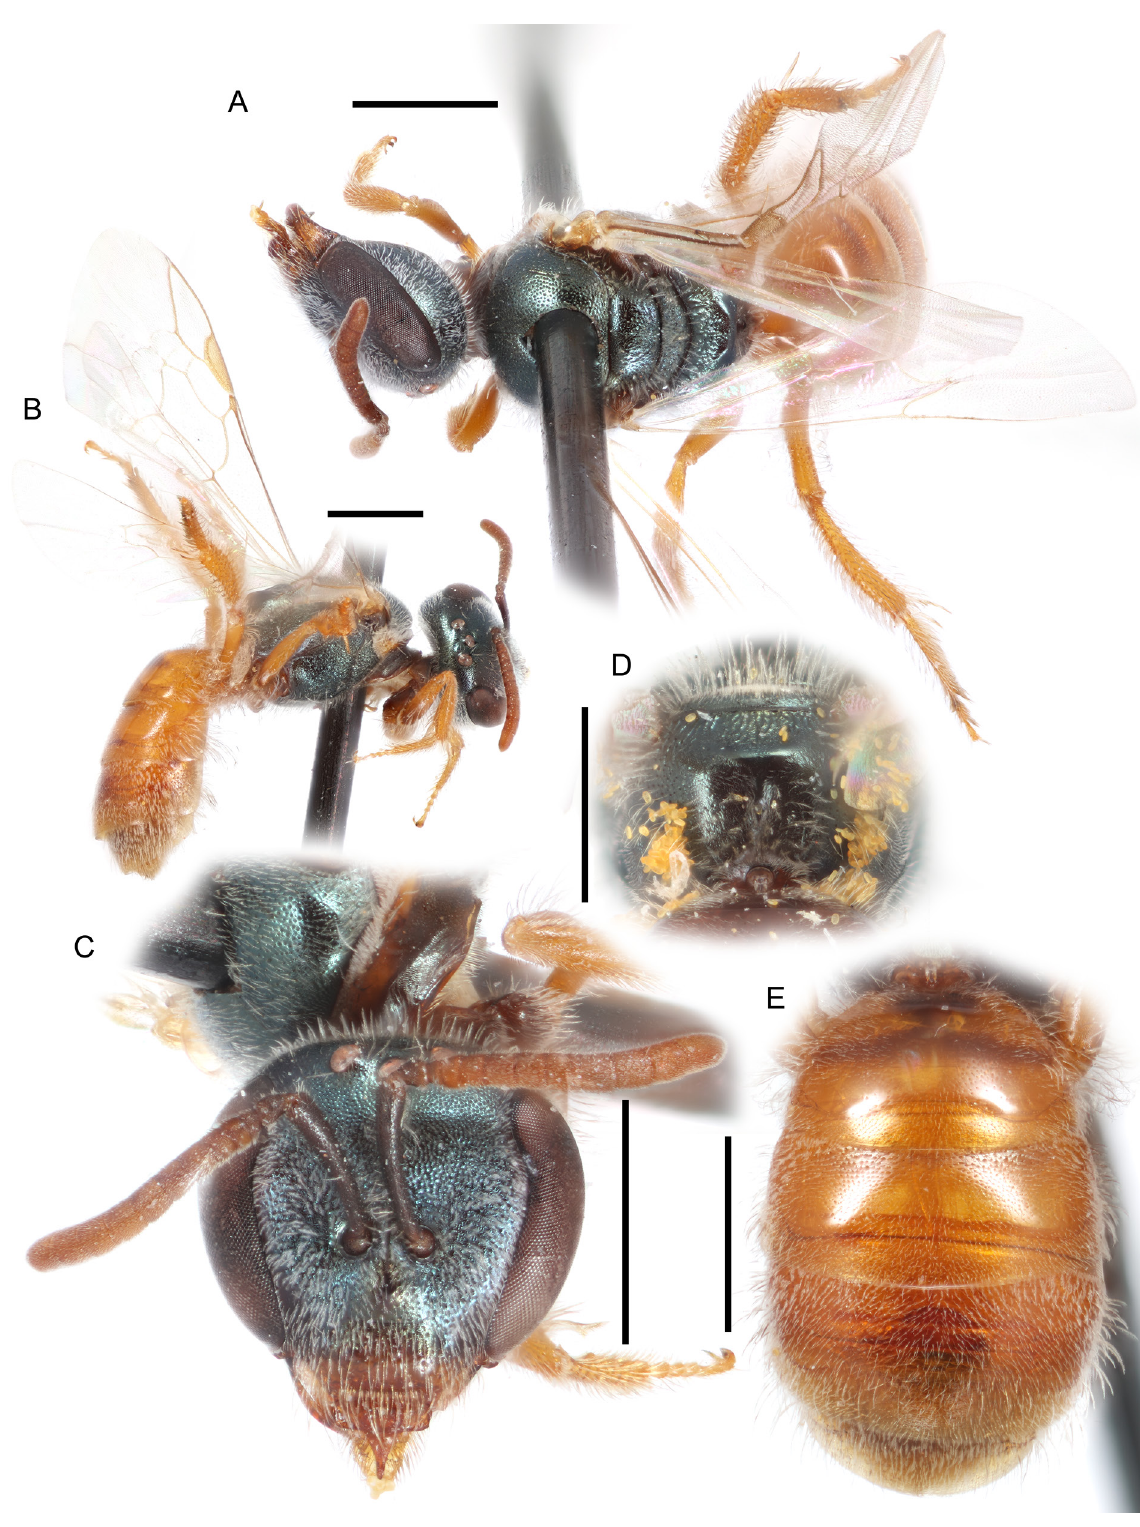
Fig. 38. Lasioglossum ( D. ) festinum sp. nov., ♀. A . Dorsal habitus. B . Lateral habitus. C . Face. D . Propodeum. E . Metasoma. Scale bars: 1